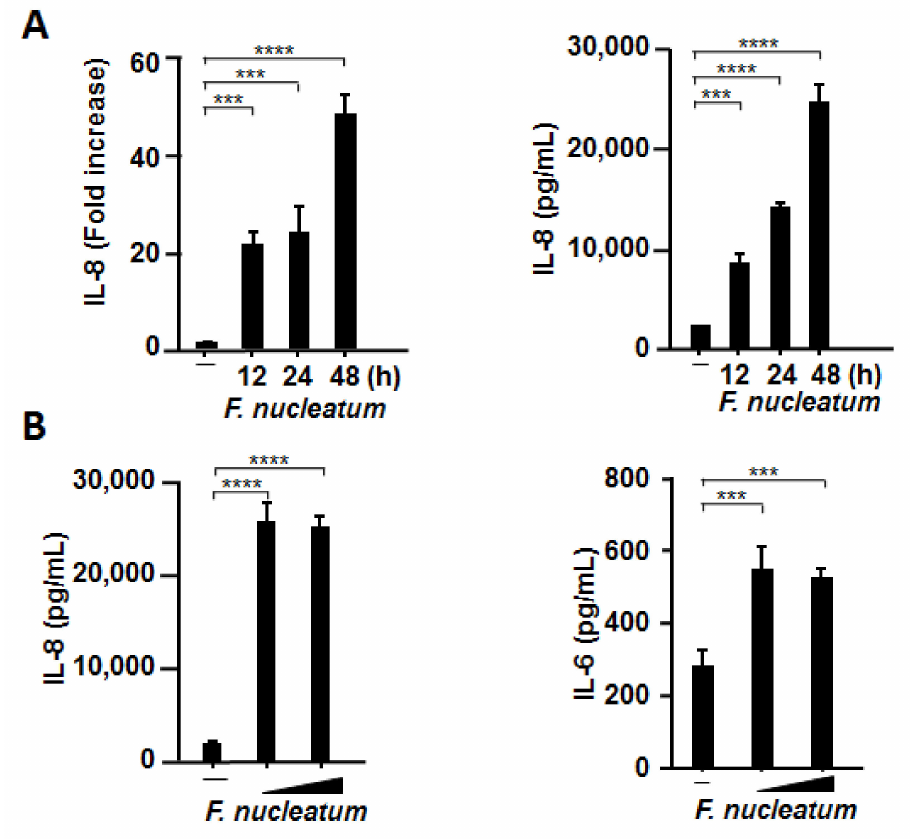
Figure 3. CSF induces mRNA expression and protein production of proinflammatory cytokines by primary human alveolar epithelial cells. Primary human alveolar epithelial cells were exposed to CSF (100 µ L/mL) for the indicated times ( A ) or at different concentrations (50 or 100 µ L/mL) for 48 h ( B ). The cells were harvested, and IL-8 and IL-6 mRNA levels were assessed using RT- qPCR. The mRNA levels were normalized to those of glyceraldehyde-3-phosphate dehydrogenase and expressed as fold increases. IL-8 and IL-6 protein levels were determined by means of enzyme-linked immunosorbent assay and expressed as pg/mL. These experiments were conducted in triplicate, and data are presented as the mean ± SD; n = 3 (***, p < 0.005; ****, p <